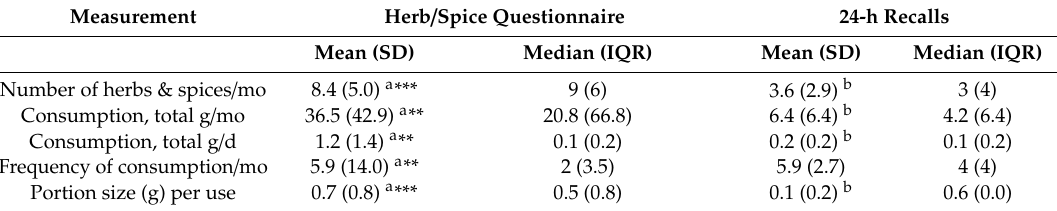
Table 4. Mean and median herb and spice intakes collected by the herb / spice questionnaire and 24-h